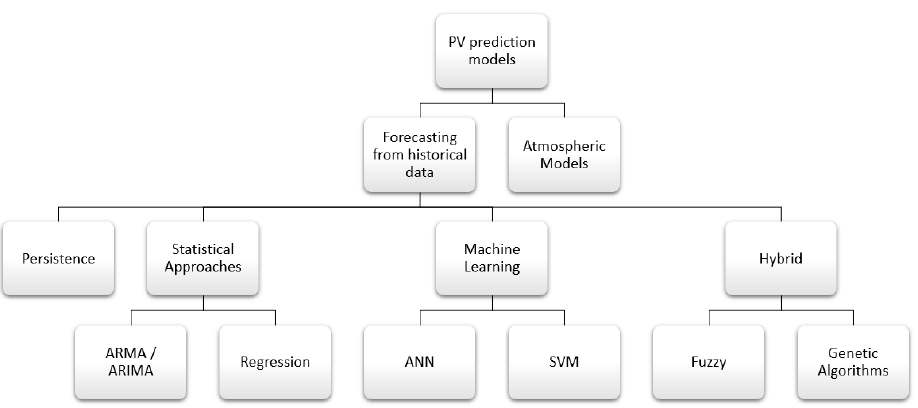
Figure 2. Classification of PV Prediction models and techniques (adapted from [12,13,18])